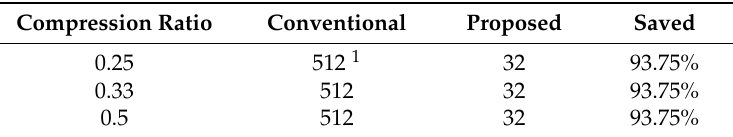
Figure 6. Influence of compression ratio on the ROC. Table 1. Computational Complexity Required.